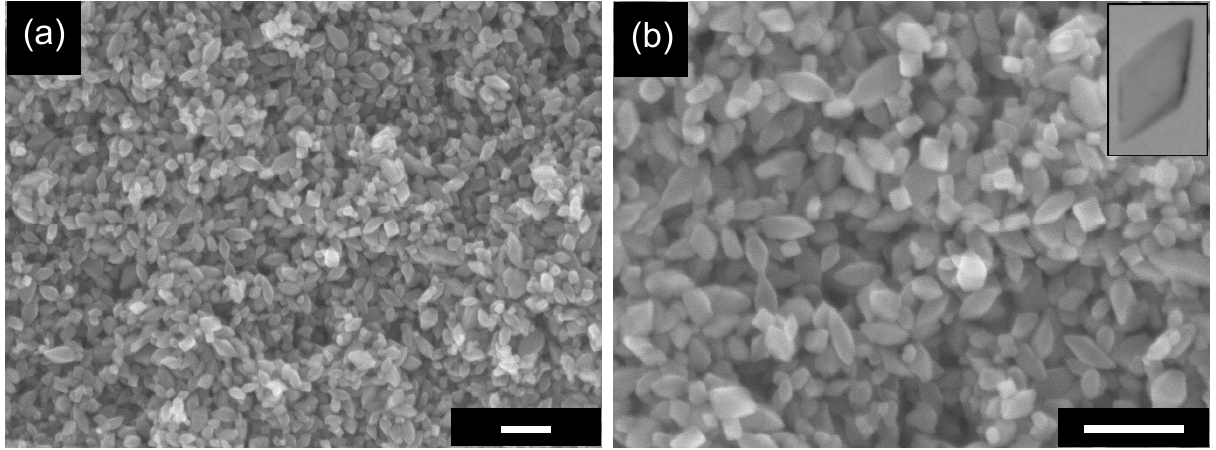
Figure 1. SEM images with ( a ) low magnification and ( b ) high magnification of the original OAP-containing sample. Scale bar: 100 nm.